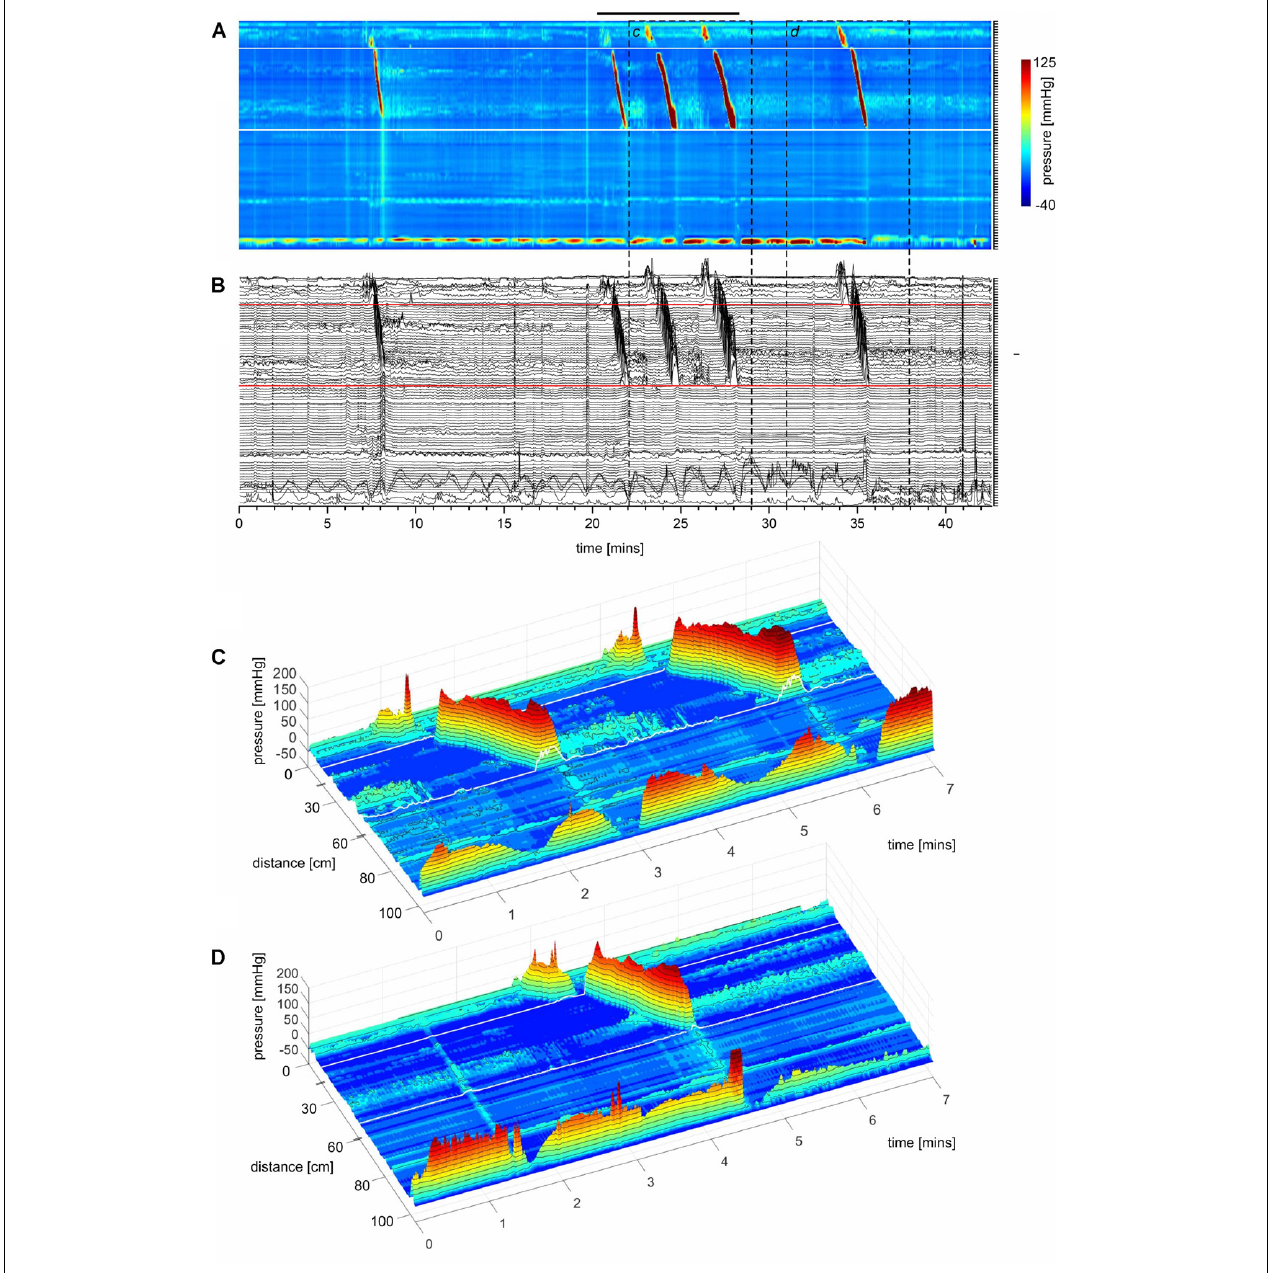
FIGURE 1 | A HAPW that develops into a SPW in response to proximal balloon distention, the HAPW-SPW. In this and all other figure panels, the position of a balloon is indicated by a white line. This means that there are 10 cm gaps in this recording at the two white lines. Hence a recording including 80 sensors will have a total reach of 100 cm. In (A,B) , the dashes at the right side of the figure represent the position of the sensors (80 sensors were in the colon, spaced 1 cm apart). The proximal colon is at the top of the figures. In (C,D) on the distance axis, 0 is the location of the most proximal sensor. (A) The time period of proximal balloon distention by 240 ml air is indicated by the black line above (A) . The balloon is positioned at the proximal white line. Proximal HAPWs developed into SPWs (generating HAPW-SPWs) associated with extensive anal sphincter relaxation. Extensive haustral activity (see Chen et al., 2017; Quan et al., 2017) is seen between 30 and 35 cm following each HAPW. (B) Same as (A) , shown are the actual pressure traces. (C) Section of (A) between the first two vertical dashed lines show two HAPW-SPWs that are followed by anal sphincter relaxation. Note that the HAPW evoked by the balloon starts at the most proximal sensor or more proximal. (D) Section of (A) between the 3rd and 4th vertical dashed lines. A low amplitude SPW with anal sphincter relaxation is seen at 1.8 cm. This is followed by an HAPW-SPW and anal sphincter relaxation; the relaxation is preceded by a brief voluntary external anal sphincter contraction. The subject was asked a minute after the motor pattern occurred whether or not the sphincter was voluntarily squeezed. The first HAPW-SPW during balloon distention was associated with bloating, the second with a feeling of urgency. The HAPW-SPW that occurred ∼ 5 min after balloon distention was associated with urgency. The SPW was not associated with gas or liquid